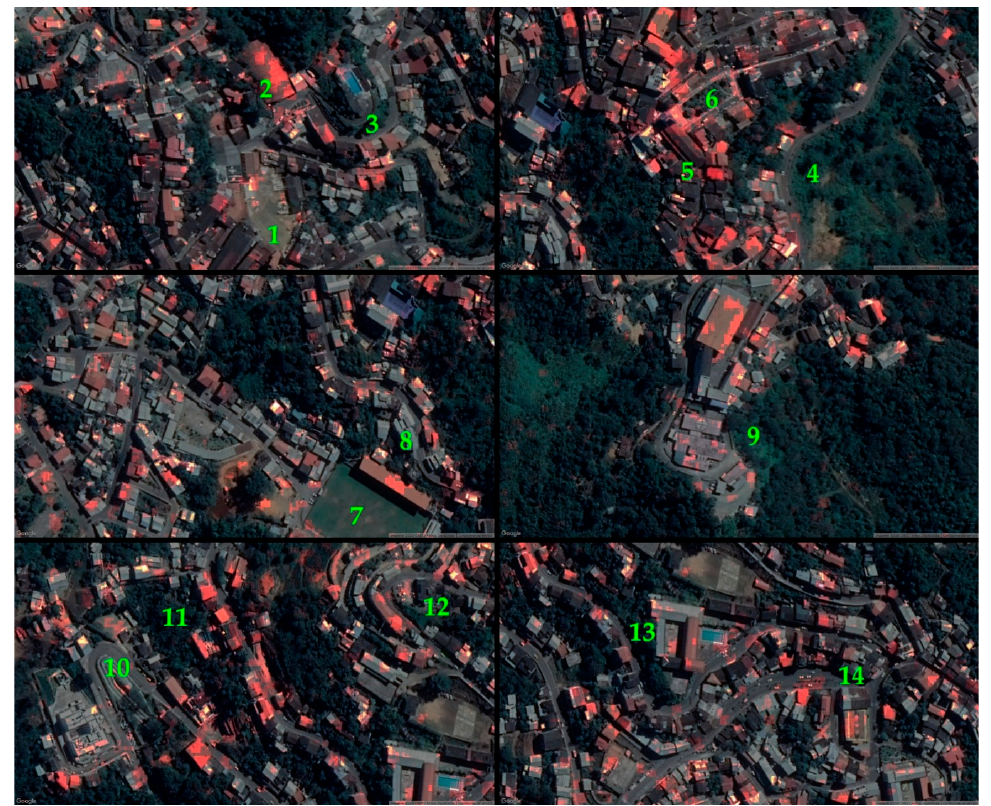
Figure 14. DInSAR analysis, determined that there are many constructions with potential sinkholes in some sectors of the city (red spots on the roofs). some sectors of the city (red spots on the